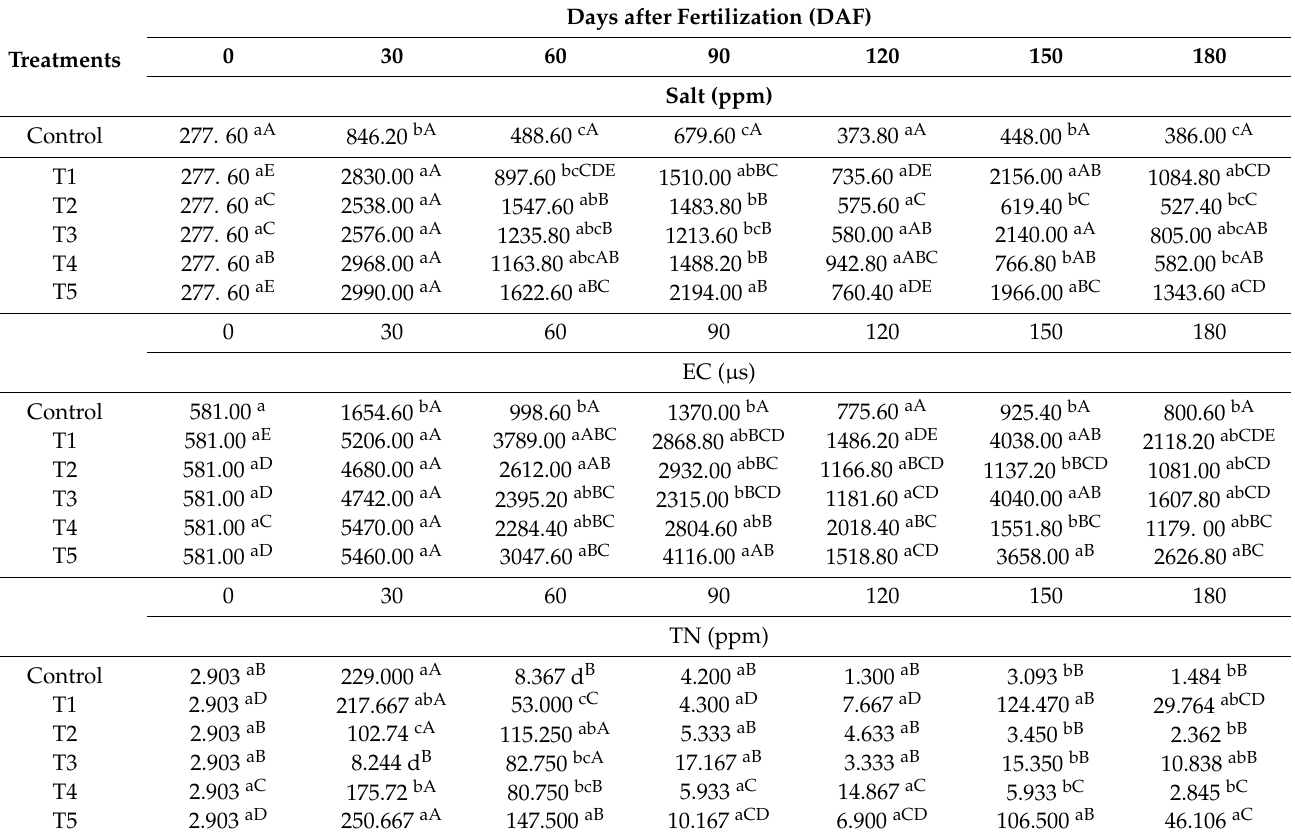
Table 5. Salt, electric conductivity (EC), and total nitrogen (TN) of leachate samples of cocoplum plants grown in different fertilization rate at 0, 30, 60, 90, 120, 150, and 180 days after